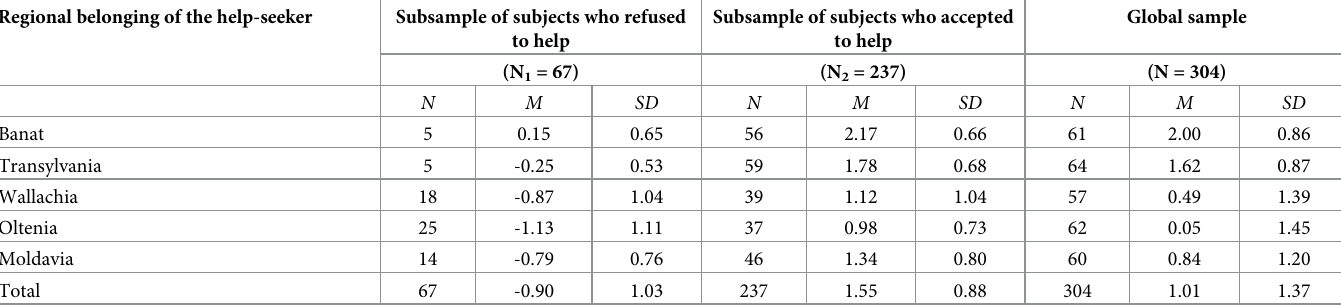
Table 3. Means and standard deviations for emotional expressiveness as a function of regional belonging of help-seeker. Regional belonging of the help-seeker